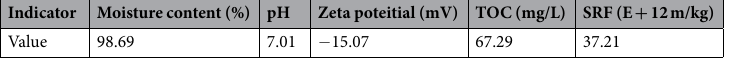
Table 1. Characteristics of waste